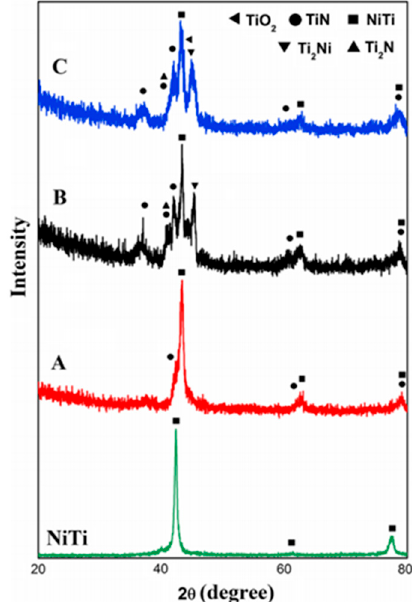
Figure 9. Low angle XRD phase analysis of NiTi surface implanted by nitrogen ions: A, B and C indicated the intensities at different concentration of nitrogen, such as 6.9 × 10 17 ion cm − 2 (sample A) 1.4 × 10 18 ion cm − 2 (sample B), and 1.8 × 10 18 ion cm − 2 (sample C). Reproduced with permission from [161].